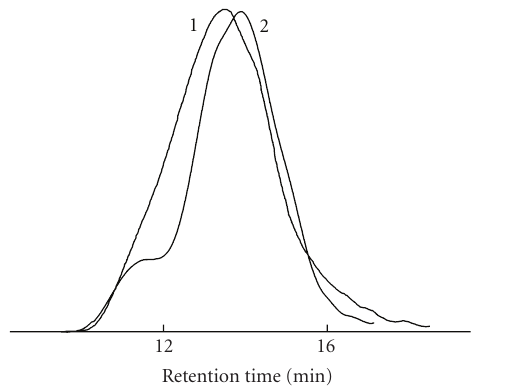
Figure 7: Chain-length distribution of PMMA obtained by pho- topolymerization of MMA in the presence 10wt% of PI 1 (1) and relevant mixture